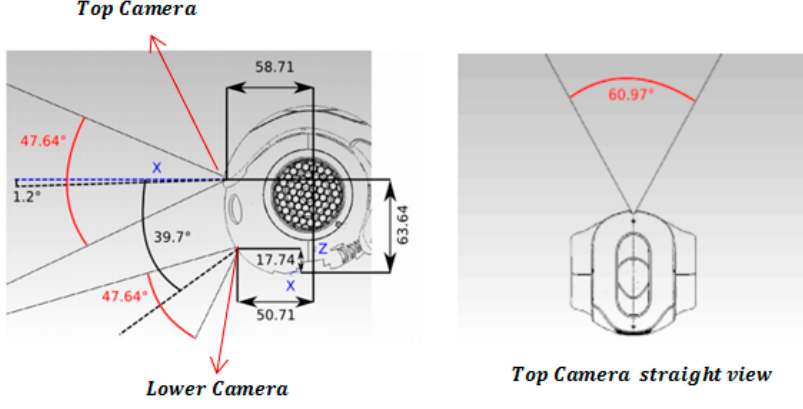
Figure 7. NAO cameras and their field of view.